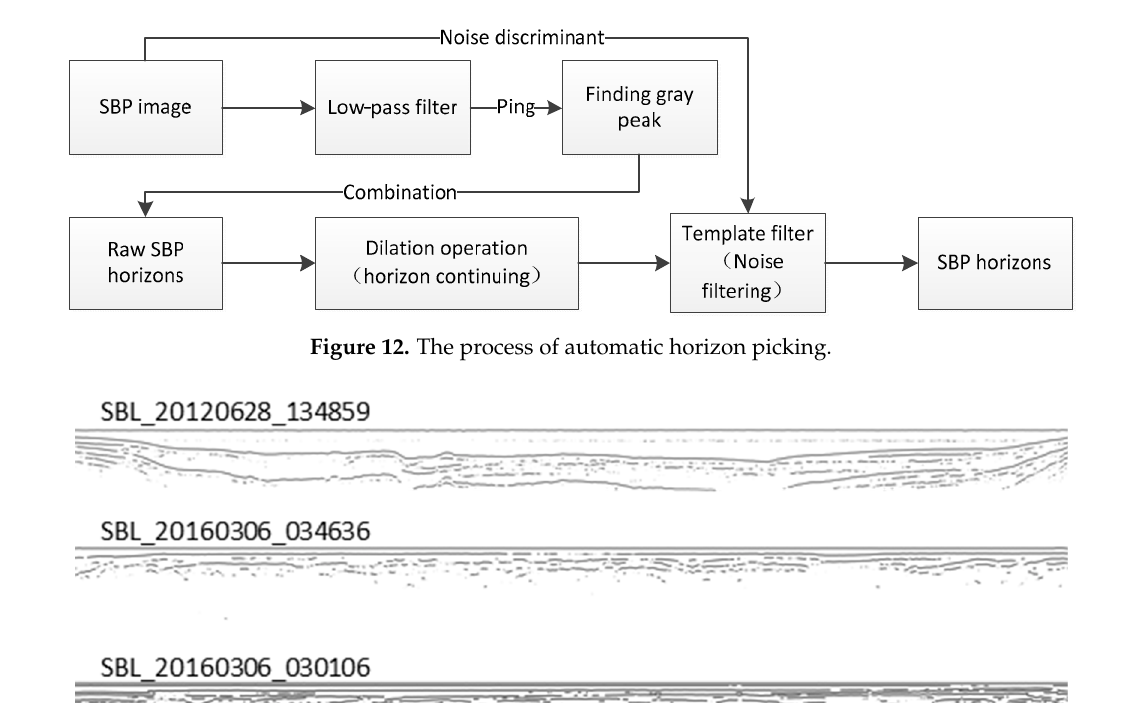
Figure 11. SBP images for training dataset.